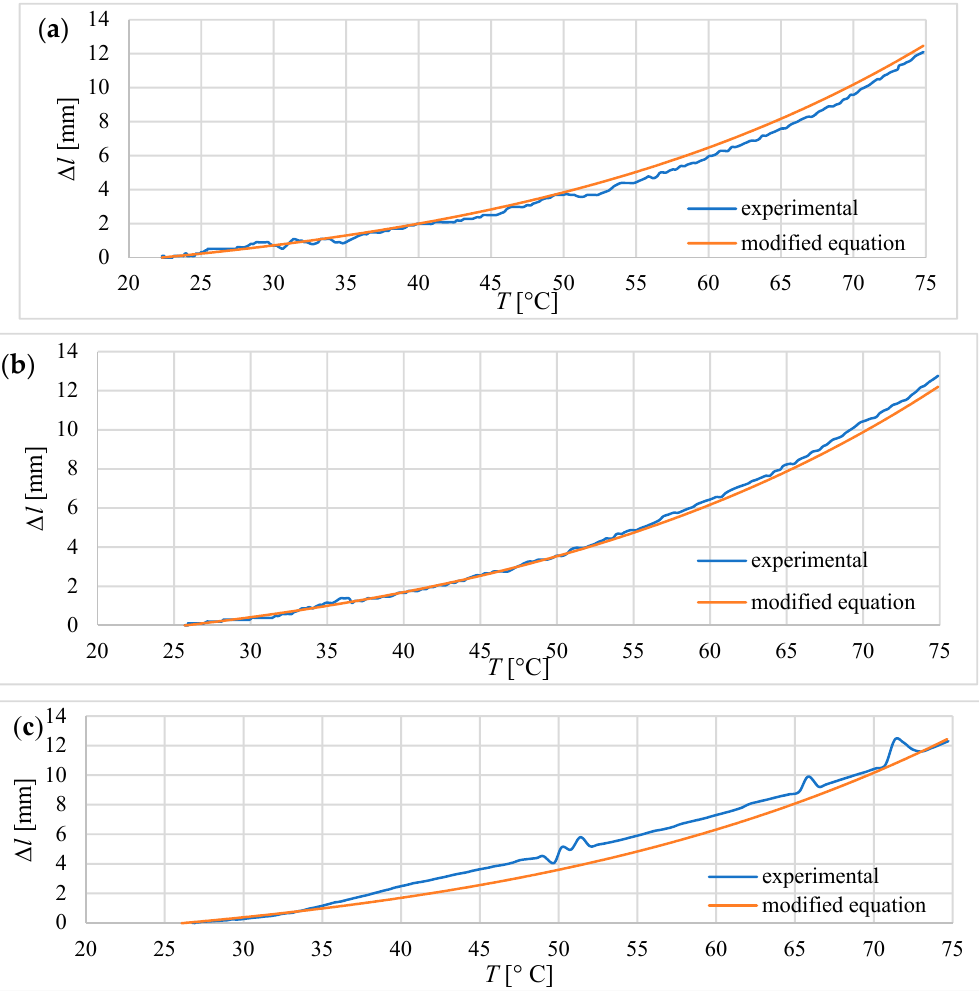
Figure 14. Experimental and calculated elongation during heating for tube actuators with different diameters and equal initial length l 0 = 40.0 mm. ( a ) elongation for tube actuator with D = 25.0 mm, ( b ) for D = 20.5 mm, ( c ) for D = 15.5 mm.